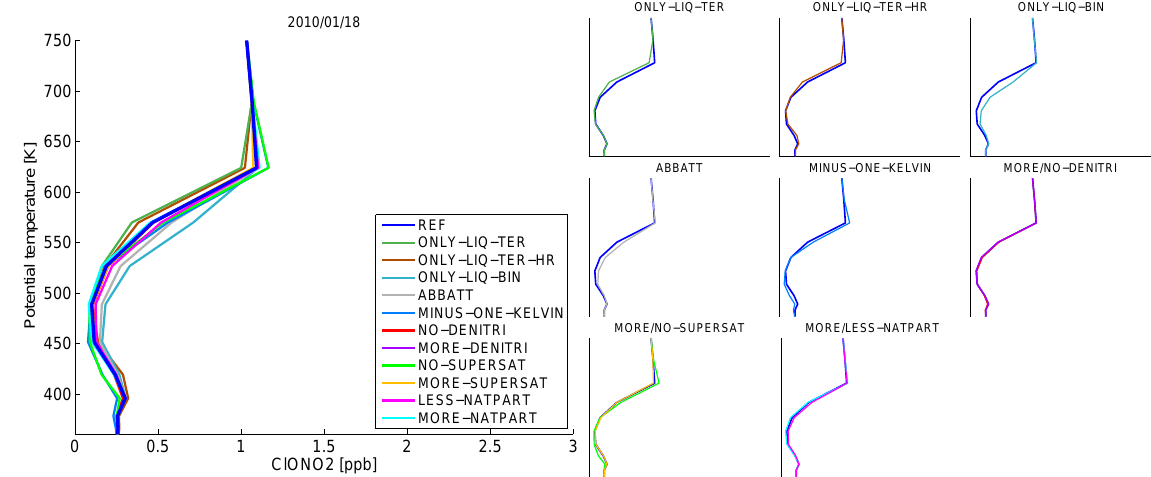
Fig. 6. Vortex-averaged ClONO 2 for 18 January 2010 as a function of potential temperature for all sensitivity runs and the reference run. The different sensitivity runs are represented by different colours. Vortex average as in Fig. 1. The small plots on the right show only one or two sensitivity runs and the reference run at the same time for clarity.